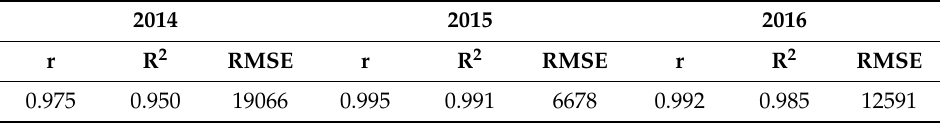
Table 3. The regression parameters after error reduction